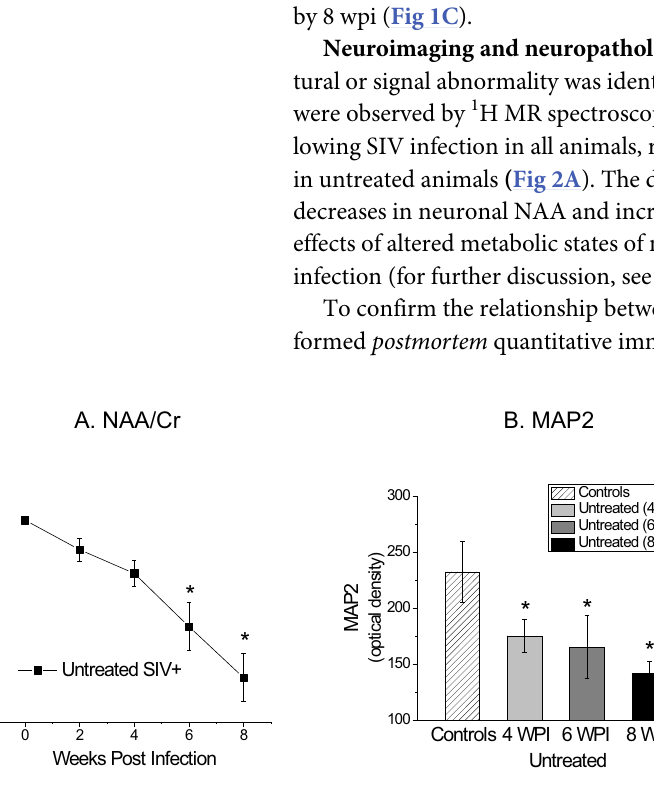
Fig 2. MRS and IHC show neuronal injury in infected animals w/o treatment. A. The neuronal marker N-Acetylasparate/creatine steadily declined following SIV infection in all animals, reaching decreased as low as 20% below baseline by 8 wpi in untreated animals. ( (cid:3) indicates significant changes from baseline levels prior infection.) B. Average microtubule-associated protein 2 levels in the frontal cortex of SIV+ untreated animals sacrificed at 4 wpi, 6 wpi and 8 wpi were lower compared to uninfected control animals. ( (cid:3) indicates significant differences from controls.) C. Average synaptophysin levels in the frontal cortex of SIV+ untreated animals sacrificed at 4 wpi, 6 wpi and 8 wpi were lower compared to uninfected control animals. ( (cid:3) indicates significant differences from controls).